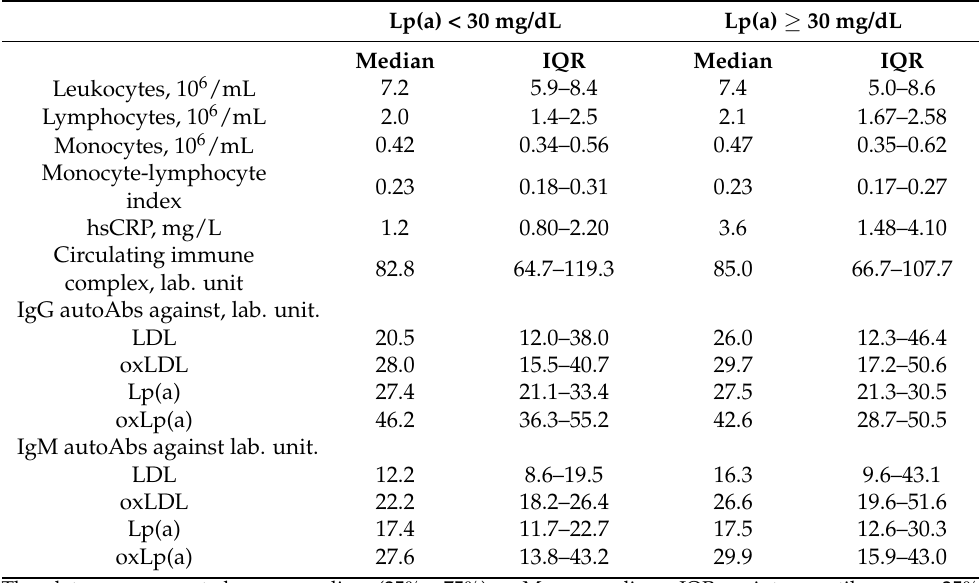
Table 2. Immune parameters in association with the lipoprotein(a)